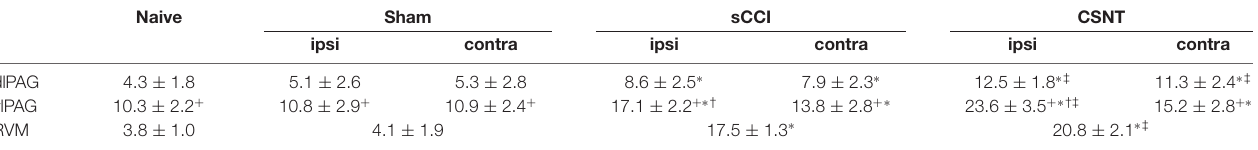
+ Significant difference (p < 0.05) compared to dlPAG. ∗ Significant difference (p < 0.05) compared to Naïve or Sham. † Significant difference (p < 0.05) compared to contralateral side. ‡ Significant difference (p < 0.05) compared to sCCI.